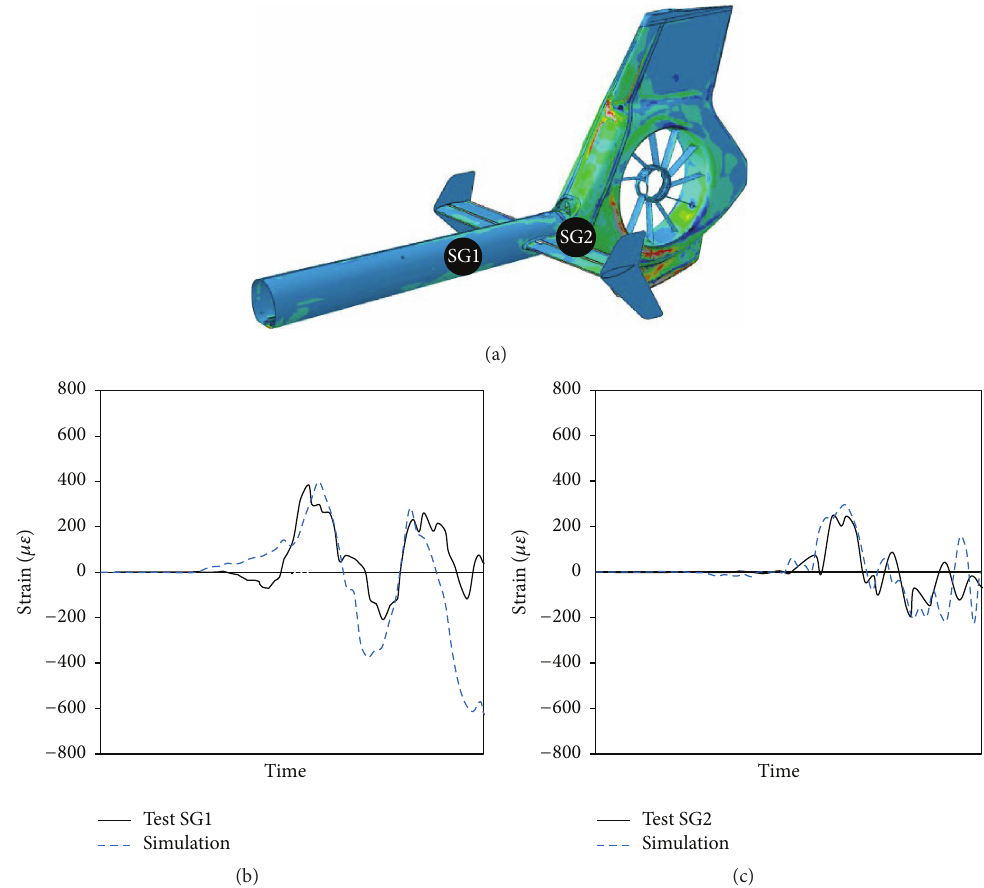
Figure 6: Exemplary contour plot of strain distribution in helicopter tail boom during shock wave loading from missile launch (a) and comparison with test data for strain gauge SG1 in front of horizontal stabiliser (b) and SG2 behind horizontal stabiliser